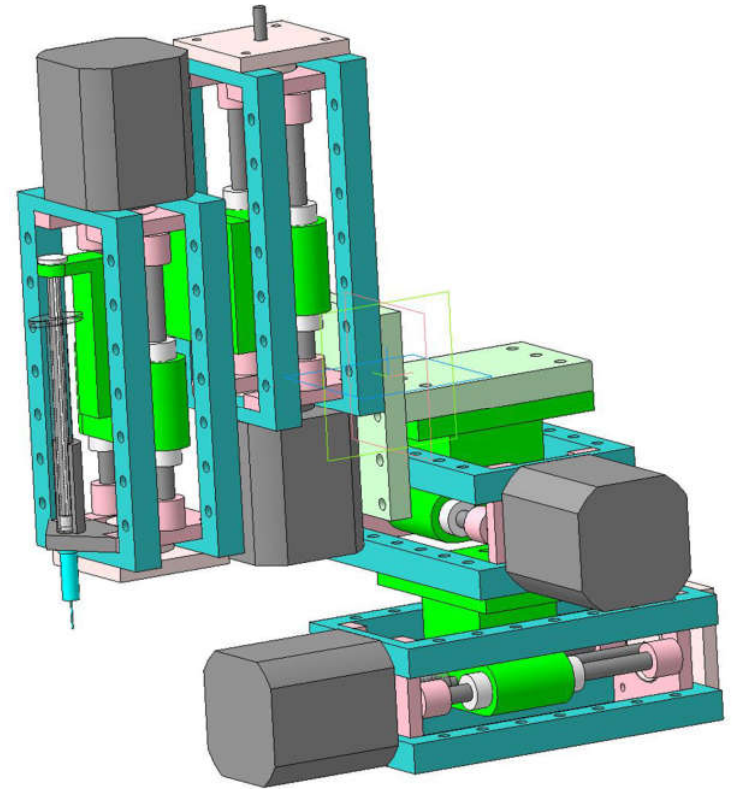
Figure 4. 3D assembly model for one probe.